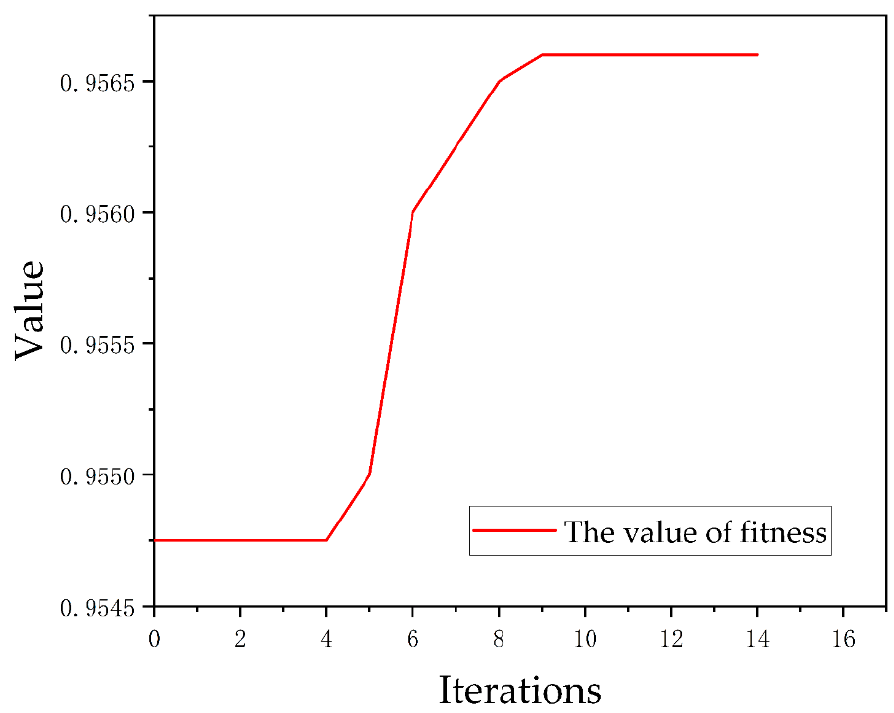
Figure 8. The variation of function maxima with the number of iterations. Table 6. The landslide susceptibility probabilities of some grid cells calculated by the four models.